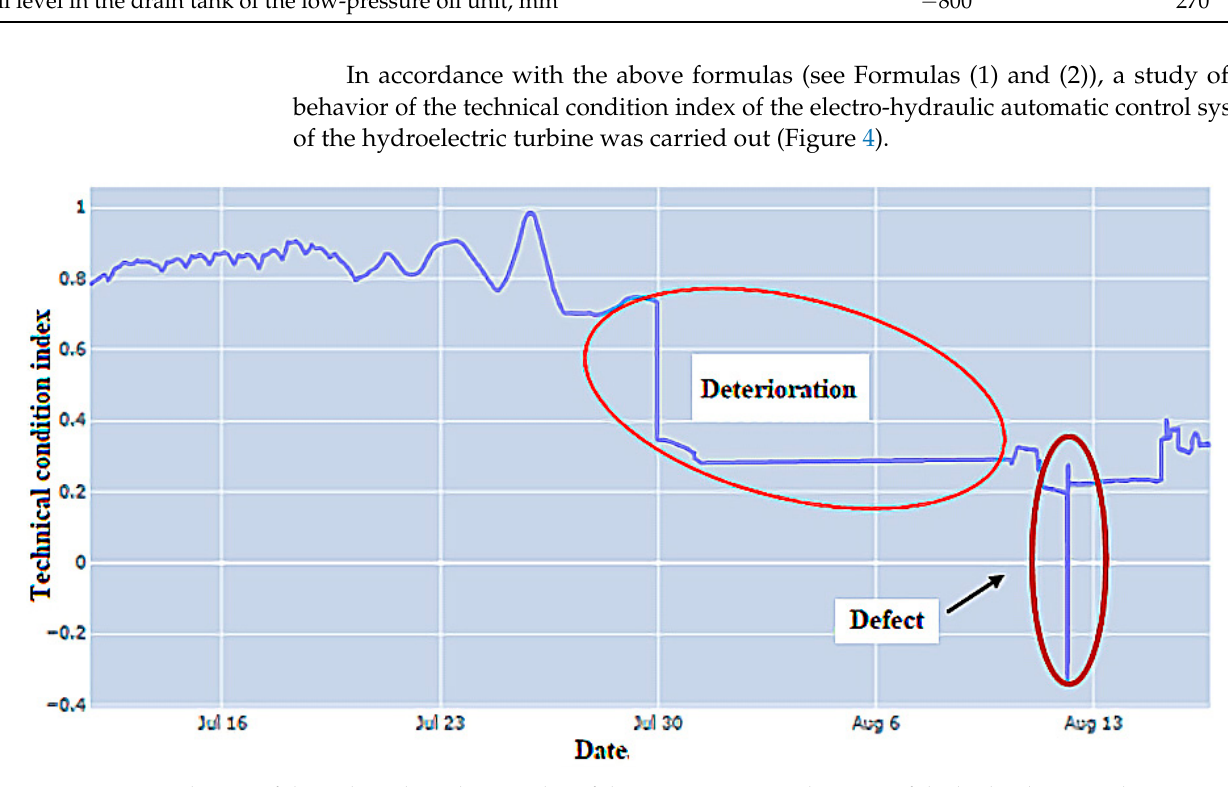
Figure 4. Behavior of the technical condition index of the automatic control system of the hydroelectric turbine. From the analysis shown on the graph, it can be seen that the generalized TCI of the automatic control system of the turbine 15 days before the detection of the defect “clogging of drainage channels” decreased from 75% to 35%. At the same time, on the day of the defect detection, the calculated TCI value became negative. This behavior of the TCI is a consequence of going beyond the upper set level of the warning alarm for the technological parameter “water level in the turbine cover” (see Figure 5) which was the cause of the